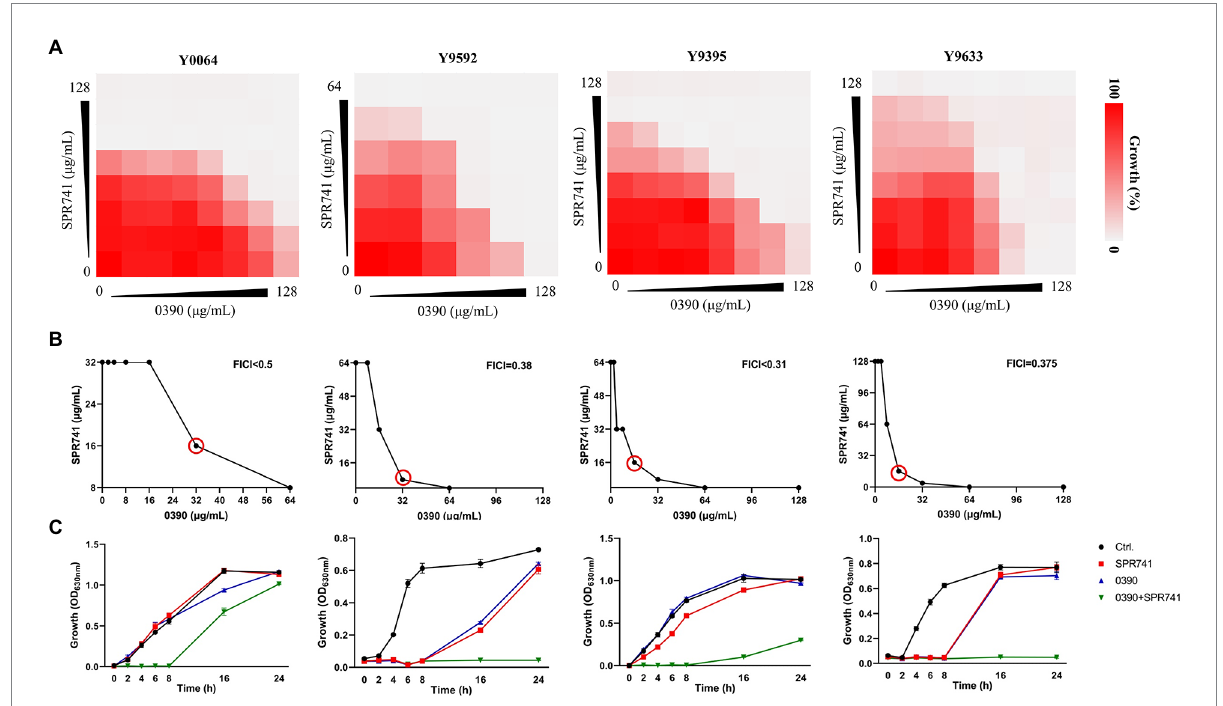
FIGURE 4 Synergistic antimicrobial activity of 0390 and SPR741 combination against Escherichia coli XDR strains. (A) Results of the drug combination assays of four E. coli XDR strains indicate synergism between 0390 and SPR741. (B) Red circles indicate the optimal FICIs. (C) Time-growth curves of the XDR strains treated with 0390 and SPR741 alone or in combination (64 μ g/ml 0390 + 8 μ g/ml SPR741 for Y0064; 16 μ g/ml 0390 + 16 μ g/ml SPR741 for Y9592; 16 μ g/ml 0390 + 16 μ g/ml SPR741 for Y9395; and 16 μ g/ml 0390 + 16 μ g/ml SPR741 for Y9633, respectively). The experiment was repeated three